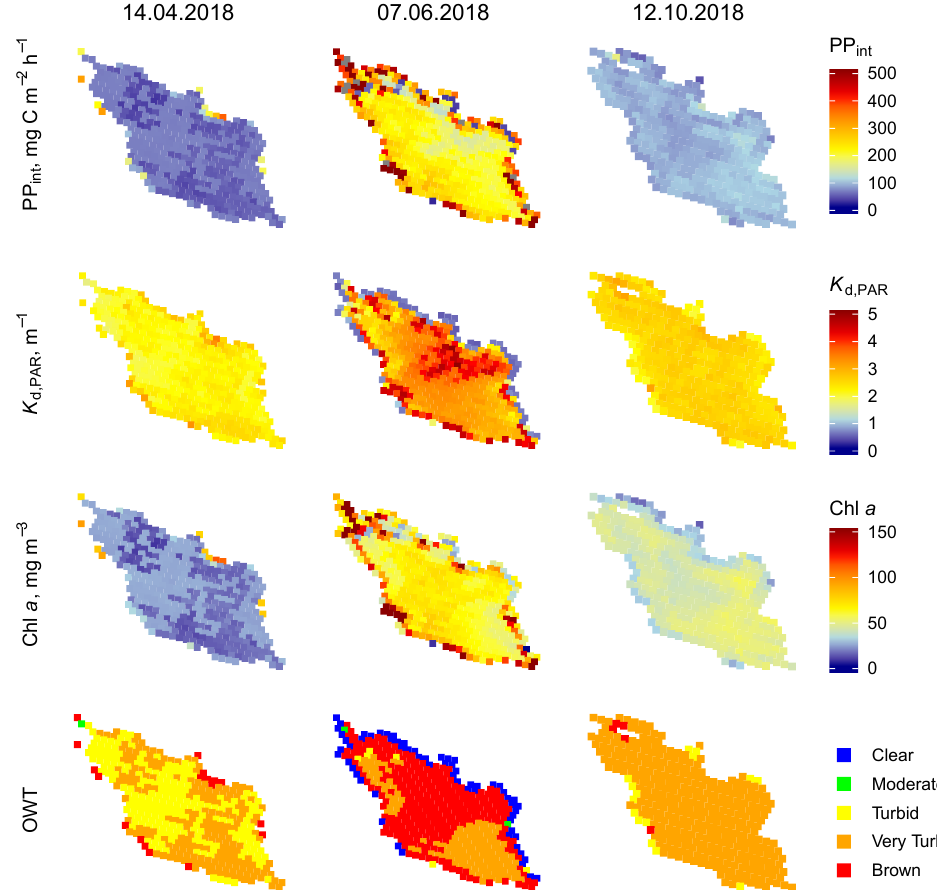
Figure 5. Three examples of the modelled integral primary production (PP int , mg C m − 2 h − 1 ) (first row), attenuation coe ffi cient in the photosynthetically active region ( K d,PAR , m − 1 ) (second row), chlorophyll- a (Chl a , mg m − 3 ) (third row), and optical water type (OWT) (fourth row) of Lake Burtnieks derived from Ocean and Land Color Instrument (OLCI)